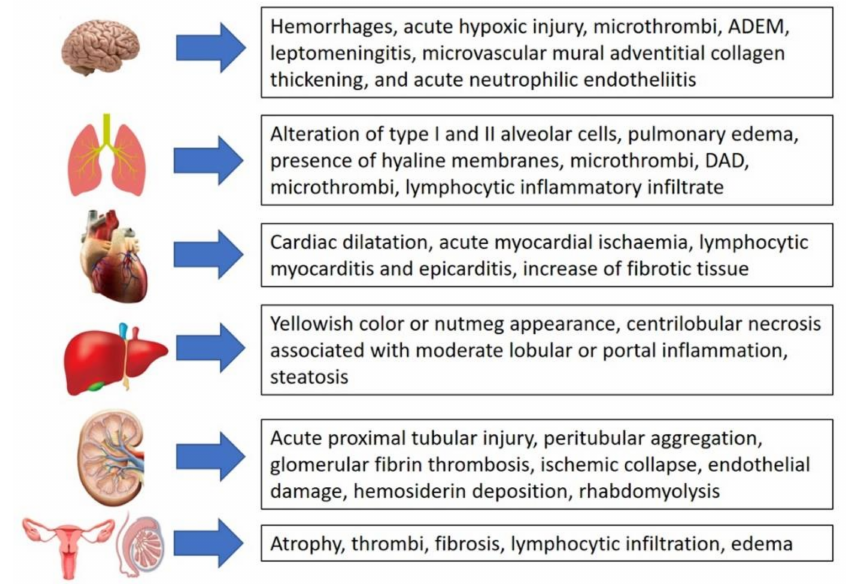
Figure 1. Summary of the main histopathological changes caused by